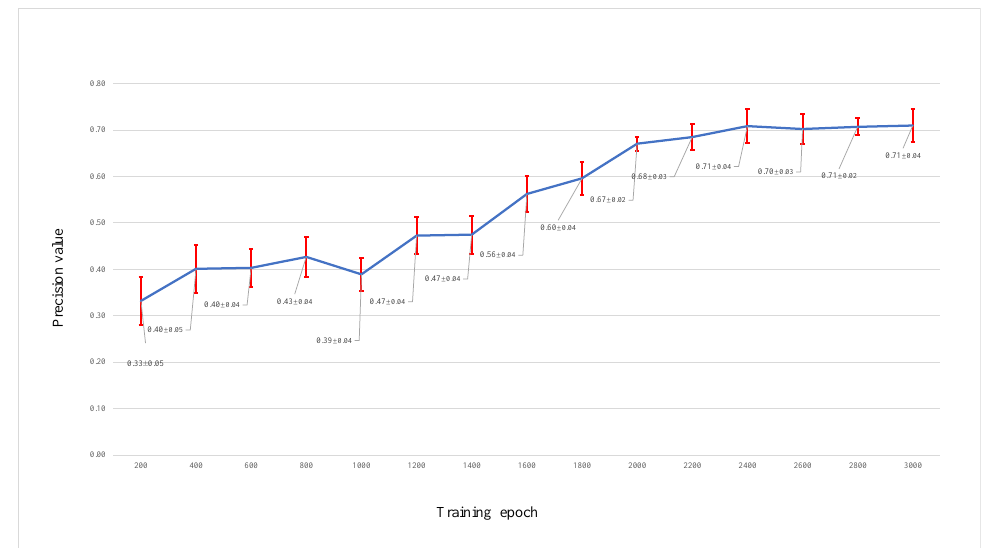
Figure 10. The prediction accuracy by trained models saved at different training epochs, the blue line shows the trend of predicion accuracy by trained models saved at different training epochs, the red line shows the range of standard err.